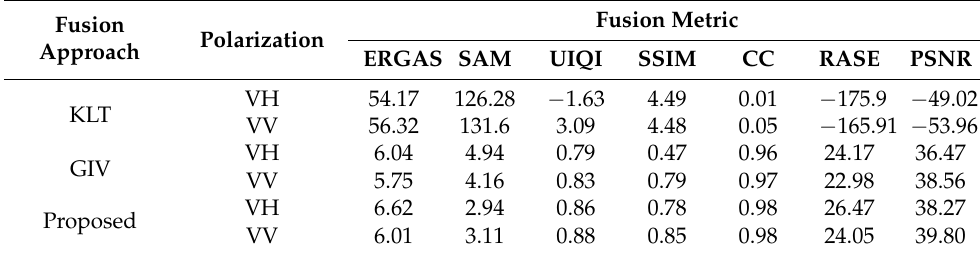
Table 2. Assessment of the Fusion Metrics of Hissar, Haryana